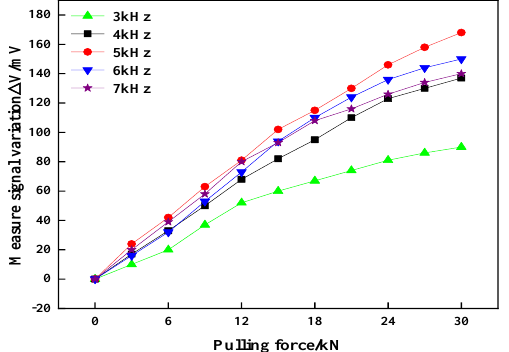
Figure 21. The curve of measuring signal of the probe with tension.